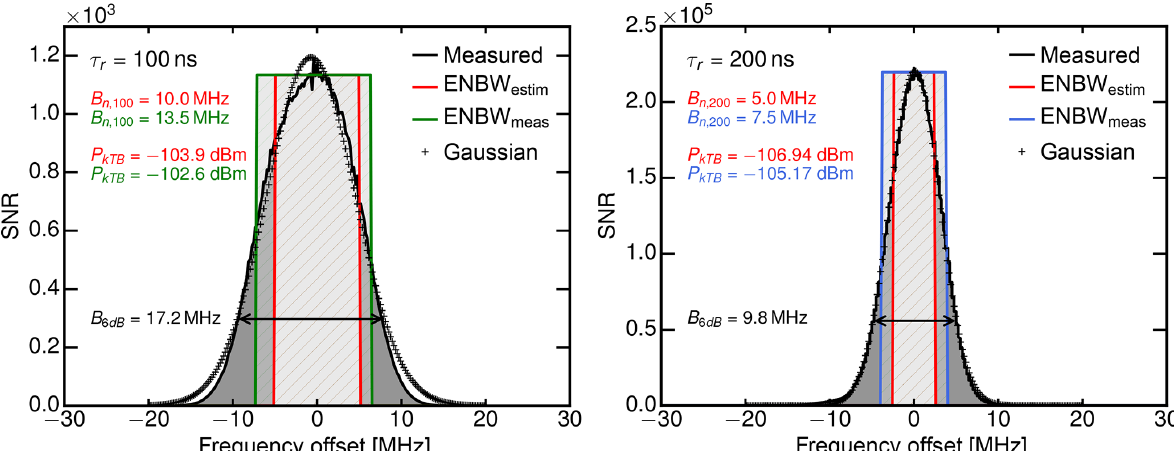
Figure 3. Measured radar receiver response (gray) as a function of the frequency offset from the center frequency at 35.5GHz for two different matched filter lengths. While the green and blue hatched rectangles show the actual equivalent noise bandwidths, the red-hatched rectangles show the estimated noise bandwidth that was used in the initial calibration.